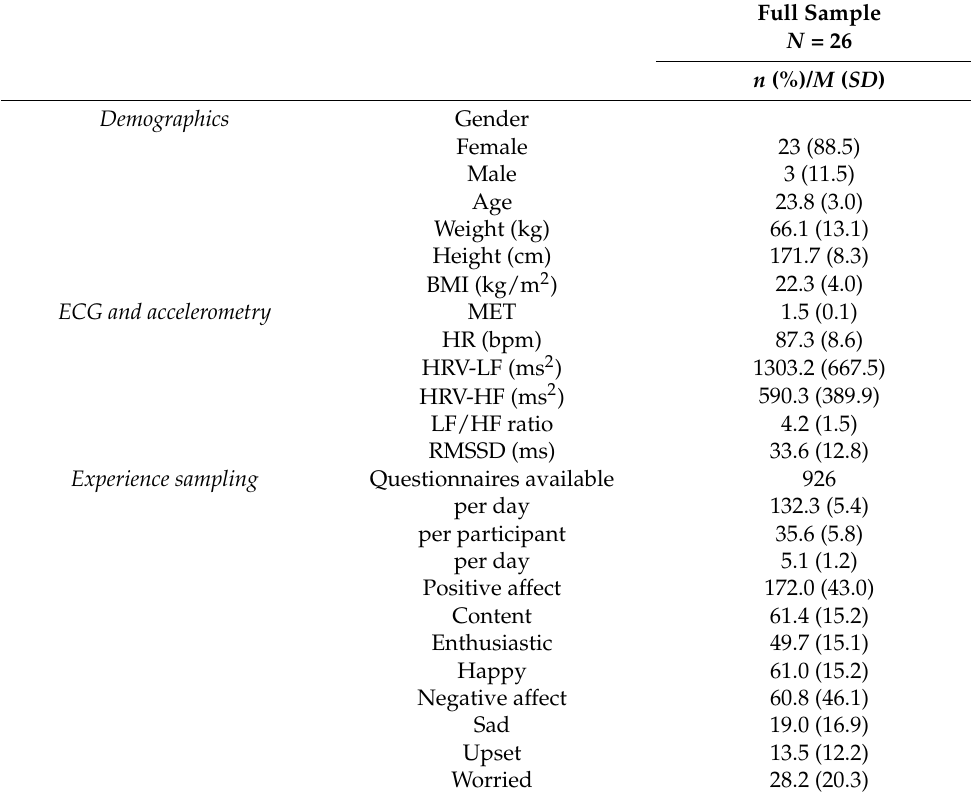
Table 2. Demographics and descriptive